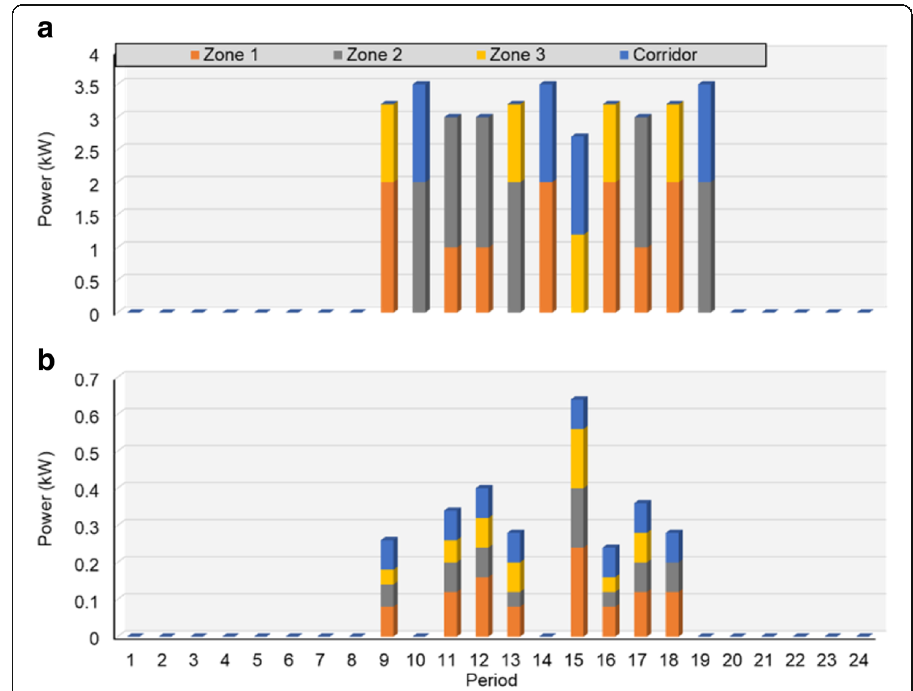
Fig. 8 Consumption scheduling details during optimization process: a AC scheduling, b Lights